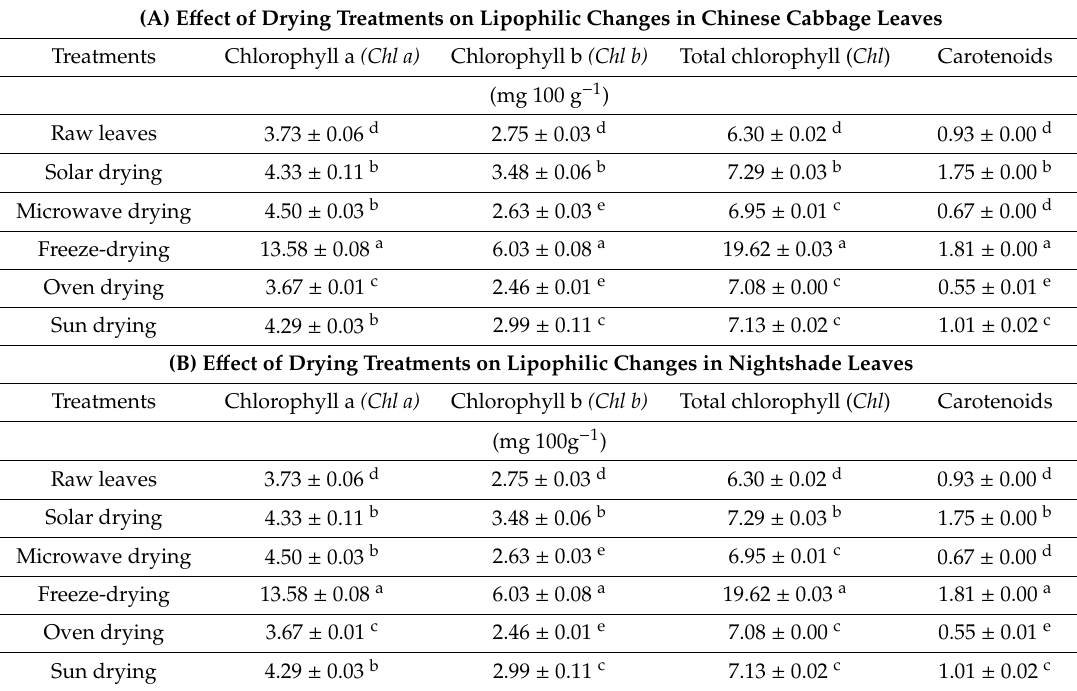
Table 2. E ff ect of drying treatments on lipophilic changes in Chinese cabbage and Nightshade